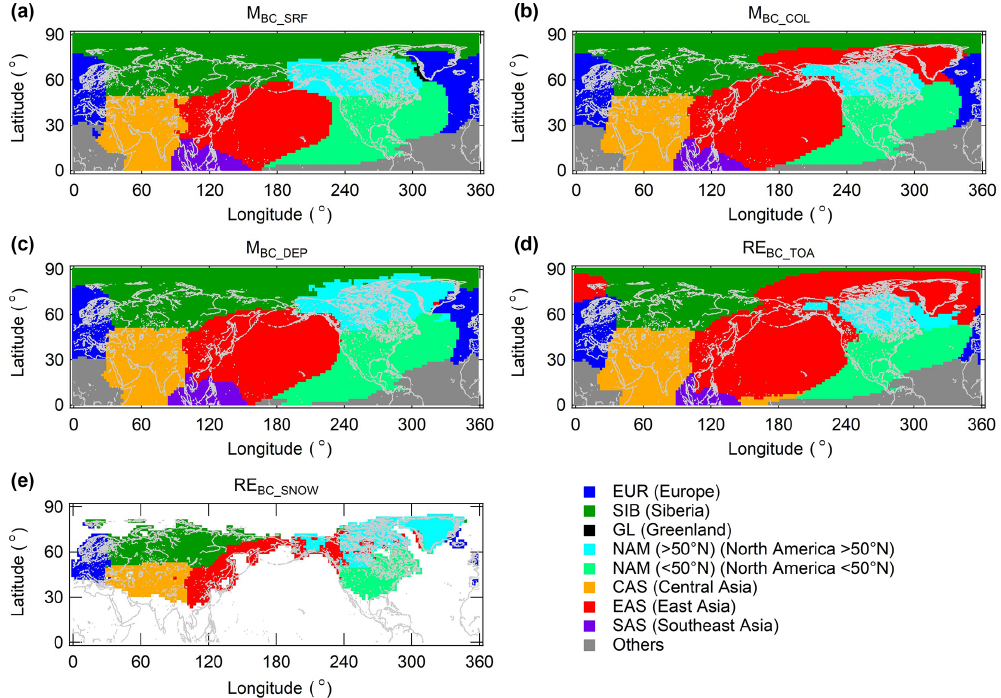
Figure 9. Spatial distributions of emission sources with the largest contribution to (a) M BC_SRF , (b) M BC_COL , (c) M BC_DEP , (d) RE BC_TOA , and (e) RE BC_SNOW among the nine source